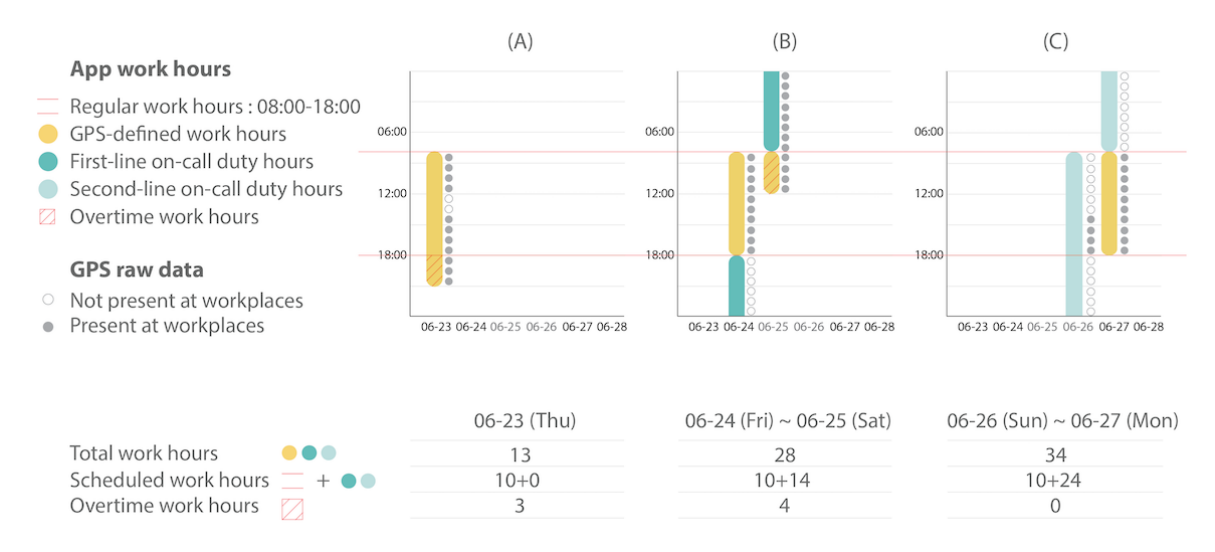
Figure 2. All types of work hours. (A) The regular work hours and overtime. (B) The on-call duty on a weekday and overtime. (C) The on-call duty on a